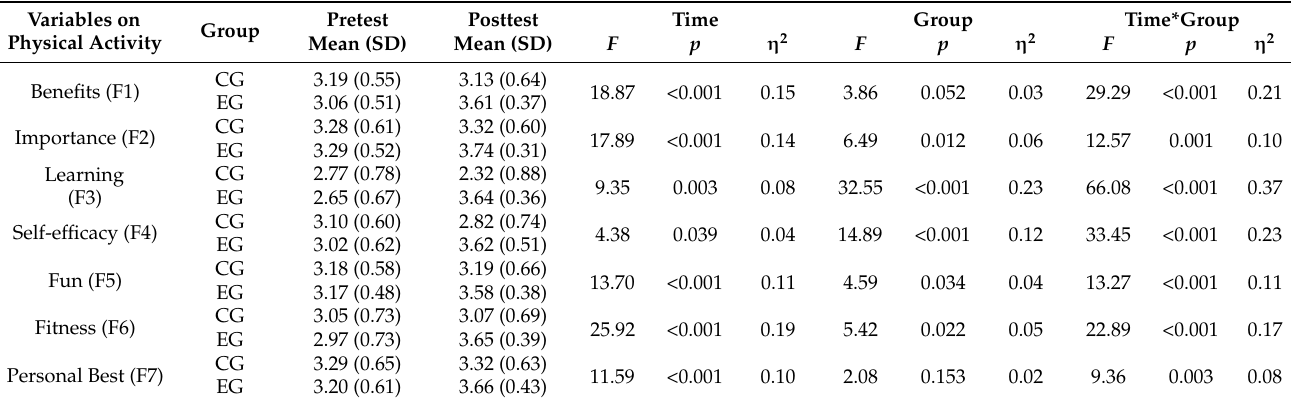
Table 3. Descriptive Statistics and ANOVA at pre-test/post-test for students in the Experimental Group (EG; n = 48) and Control Group (CG; n = 65).